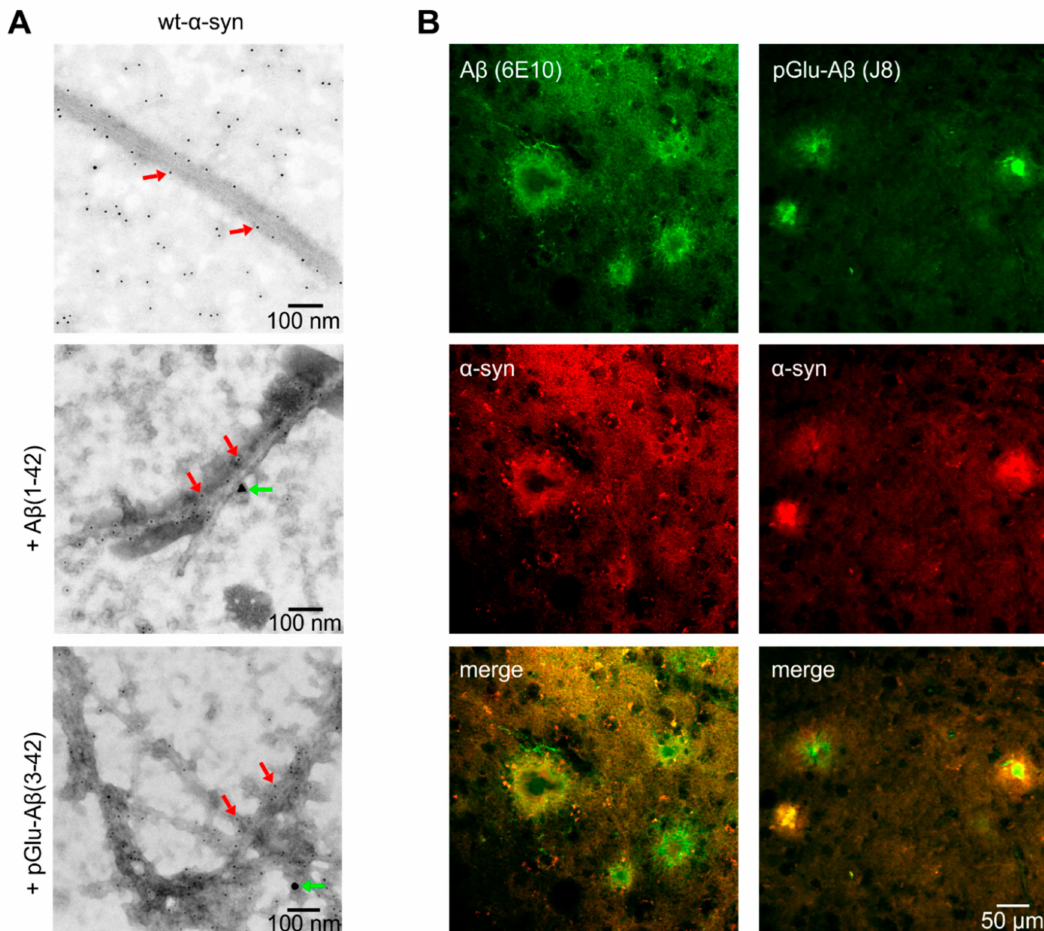
Figure 4. Co-aggregation of wt- α -synuclein with A β (1–42) and pGlu-A β (3–42) in vitro and in vivo. ( A ) TEM images of amyloid fibrils of wt- α -synuclein alone (top) or in combination with A β (1–42) (middle) or pGlu-A β (3–42) (bottom). Fibrils were labeled with immunogold particles of defined sizes to identify the di ff erent peptides: 5 nm gold particles for the α -synuclein peptides (red arrows) and 20 nm gold particles for the A β peptides (green arrows). ( B ) Double immunofluorescent labeling of A β (green) and α -synuclein (red) in the parietal cortex of Tg2576 mouse brain. The respective peptides were labeled with mouse monoclonal antibody 6E10 directed against the amino terminus of the A β peptide, the pGlu-A β -specific mouse monoclonal antibody J8, and the rabbit anti-phospho-Serin129- α -synuclein antibody ab51253, specific for aggregated α